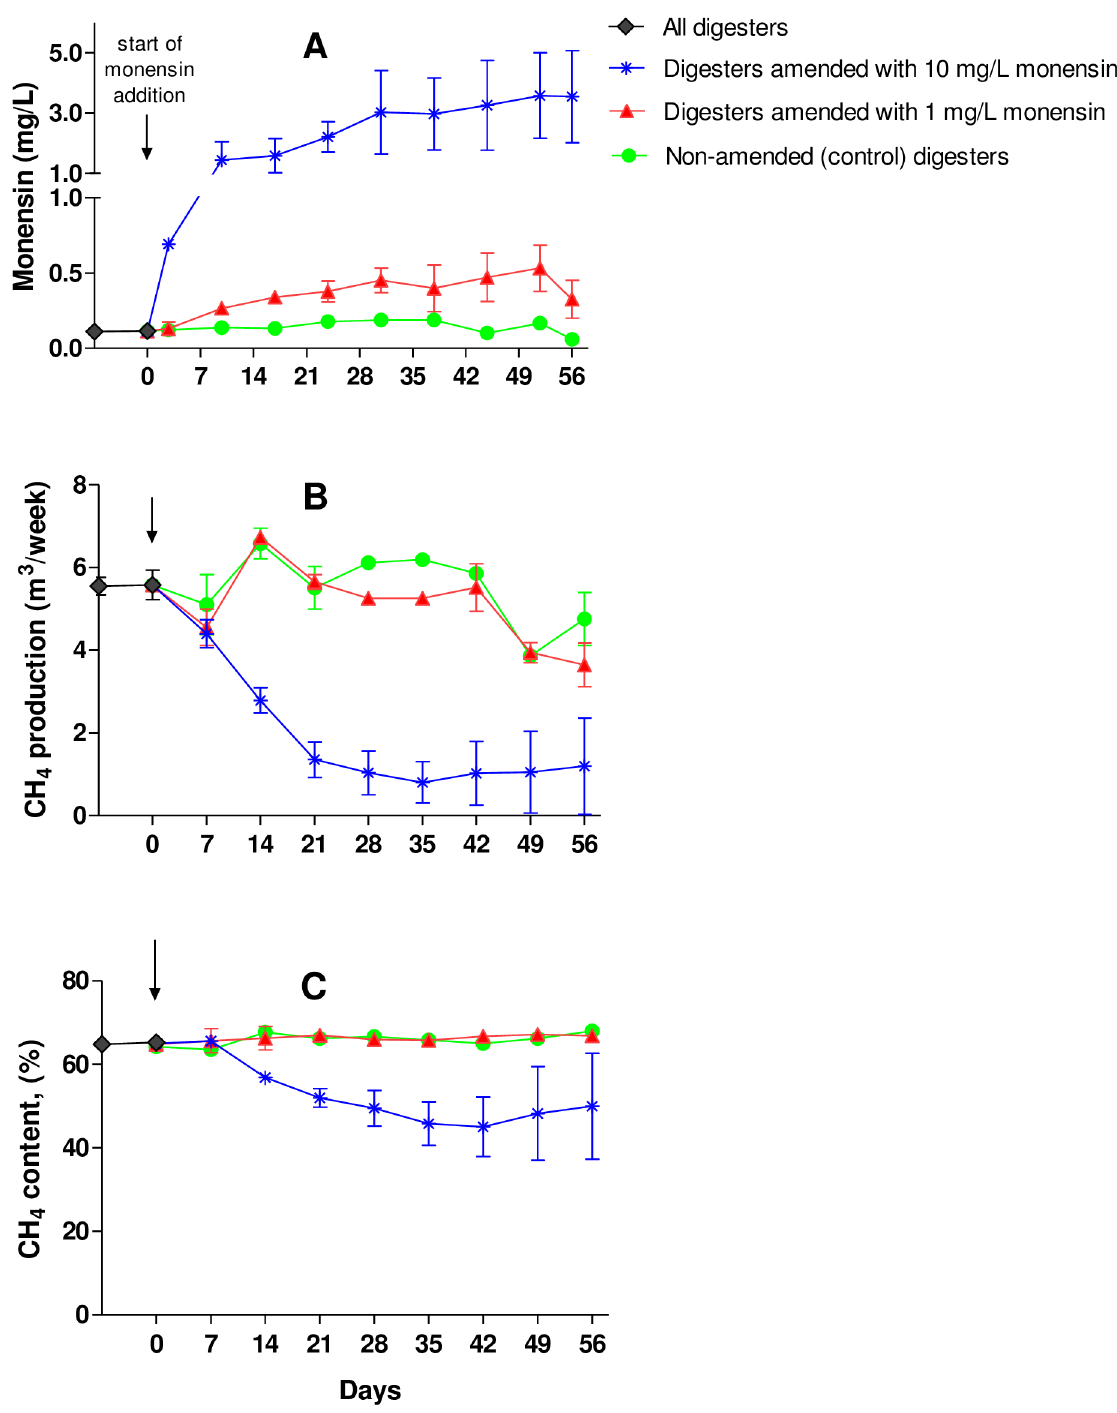
Fig 2. Effluent monensin concentrations (mg /L) (a); weekly CH 4 production (m 3 /week) (b); and CH 4 content (%) (c) from the field- scale (FS) digesters operated using dairy manure (non-amended) and dairy manure amended with monensin to 1 and 10 mg/L. Values are the means from duplicate digesters. Standard deviations are shown as error